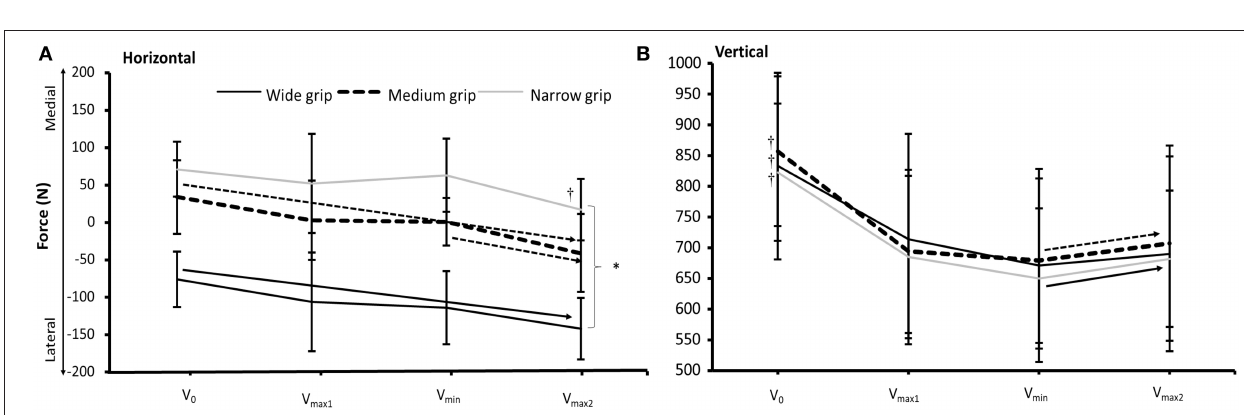
FIGURE 4 | Horizontal forces and vertical forces expressed as mean (SD) in v 0 , v max1 , v min , and v max2 for the wide, medium, and narrow grip bench press conditions. *Indicates a significant difference when compared with the other two grip widths. † Indicates a significant difference with all other events for the grip width. → Indicates a significant difference between the two specified events for this grip